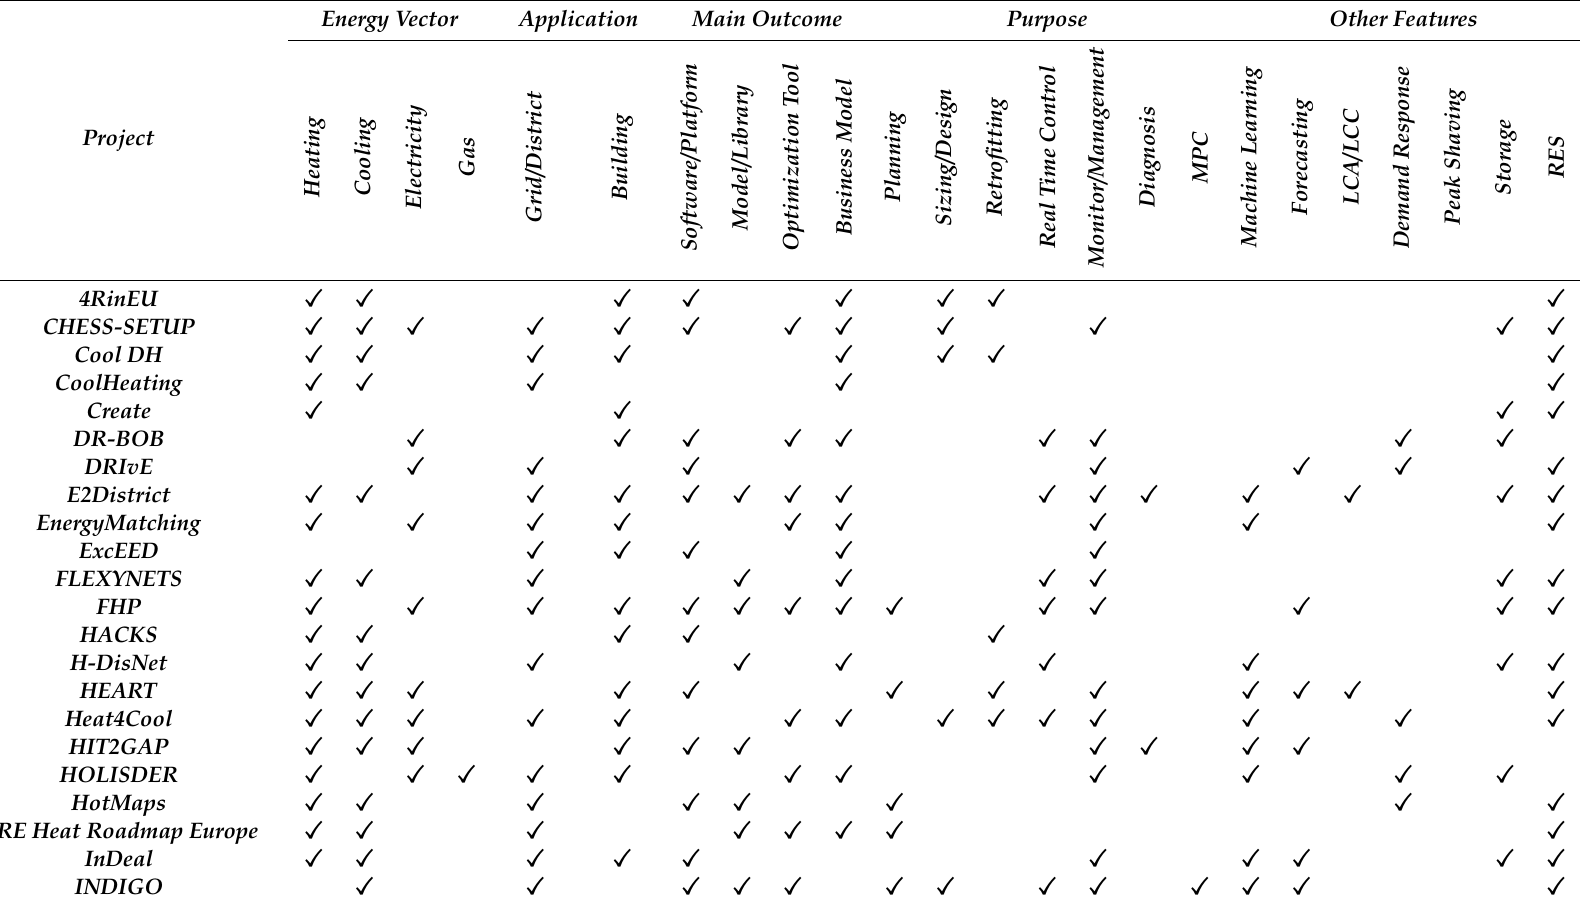
Table A2. Relevant features of the selected projects funded by the Horizon 2020 Framework Programme. Energy Vector